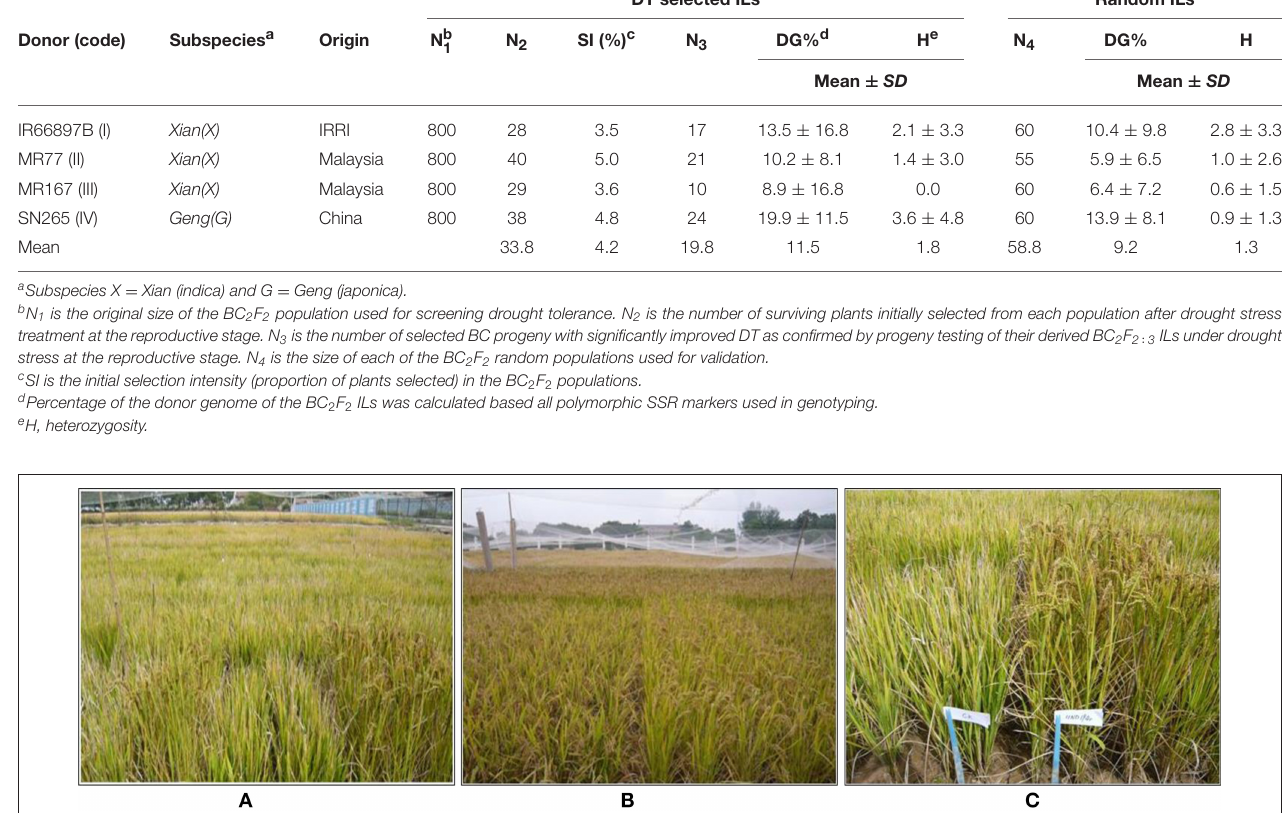
TABLE 1 | The information of 4 rice backcross populations used for improving drought tolerance in this study. DT selected ILs Random ILs